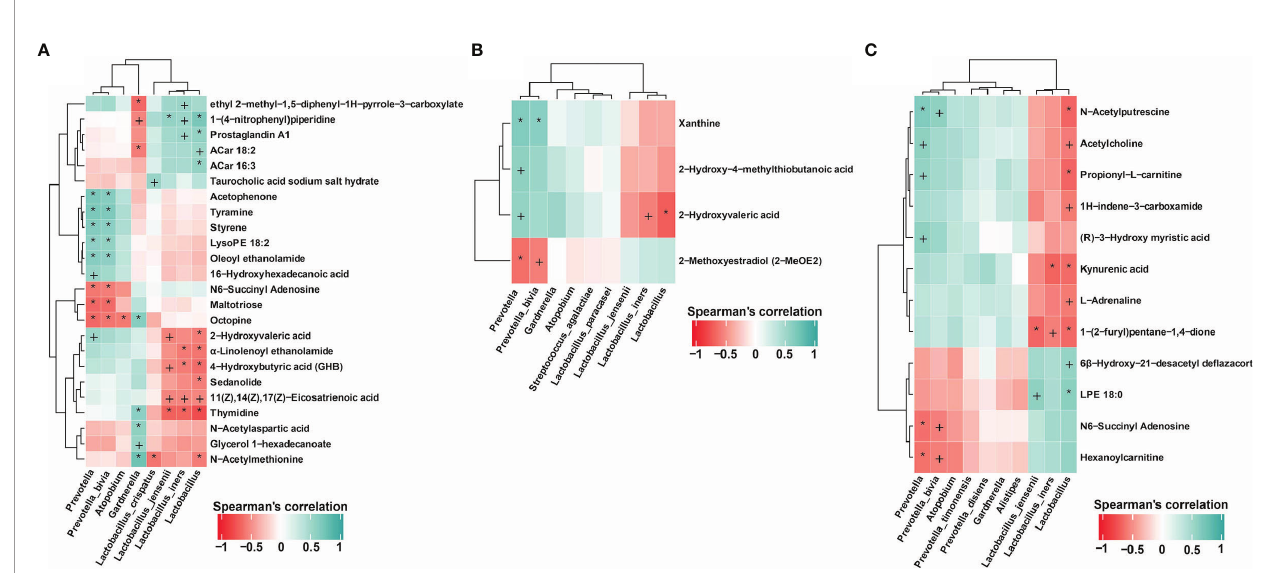
FIGURE 4 | Correlation between metabolites and key vaginal microbiota associated with the drug therapy outcomes. (A) Association of key vaginal microorganisms and metabolites in patients completely cured (M1.1, M1.2) and in patients with cured VVC and untreated BV (M2.1, M2.2). (B) Associations between key vaginal microorganisms and metabolites in completely cured patients (M1.1, M1.2) and in uncured patients (M3.1, M3.2). (C) Association of key vaginal microorganisms and metabolites in completely cured patients (M1.1, M1.2) and in patients with recurrence (MR.1, MR.2, MR.3). P value of Spearman ’ s correlation: + <0.05,